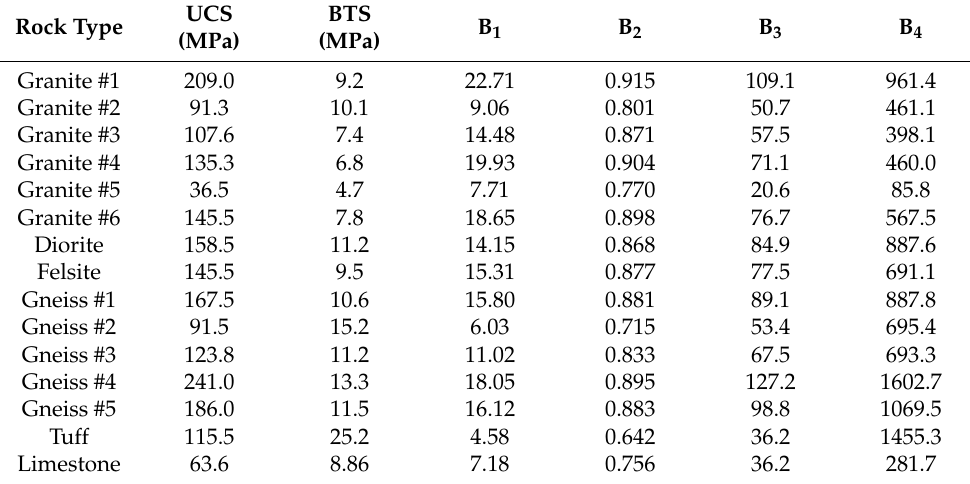
Table 2. Mechanical properties of rocks used in the linear cutting machine (LCM) tests.